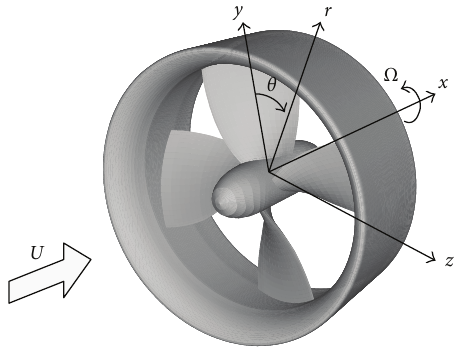
Figure 1: Propeller coordinate system.